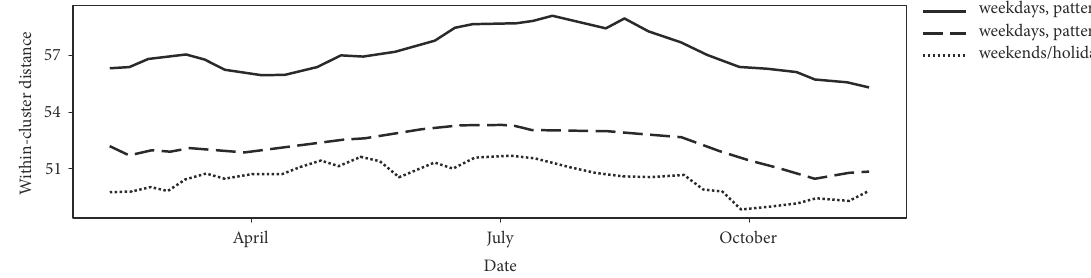
Figure 8. Variability of mobility pattern clusters (within-cluster distances, smoothed by moving